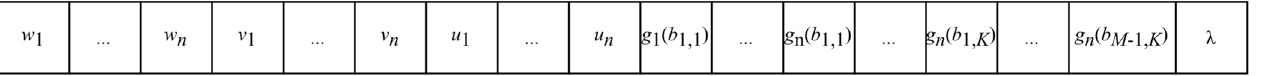
Figure 2. Individuals used in the genetic algorithm to represent nB inf